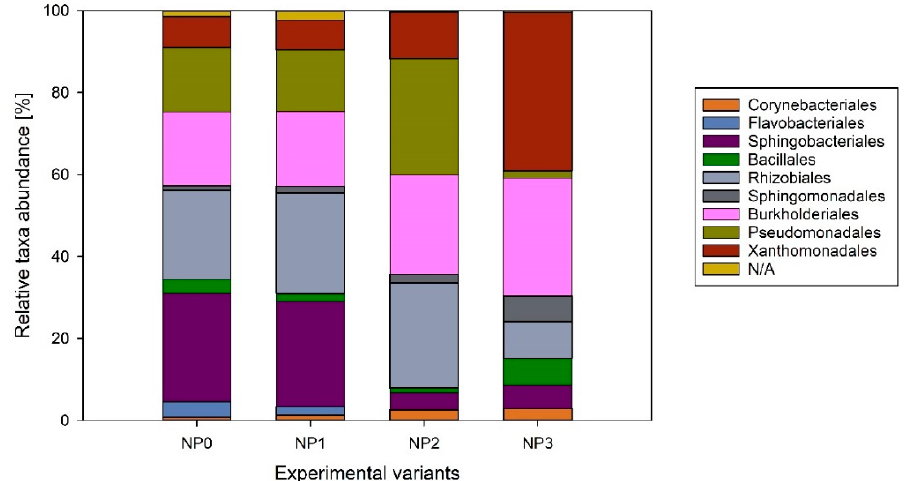
Figure 4. The relative abundance of the bacterial orders in the experimental variants after 168 h of the biodegradation process. Taxa with relative abundance below 1% are excluded from the analysis.